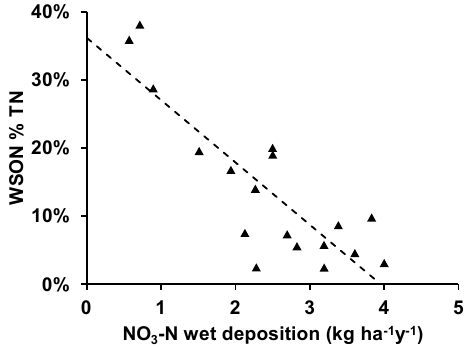
Fig. 3. As for Fig. 2, but showing WSON as % of total N in terms of wet deposition of NO 3 -N at each site.